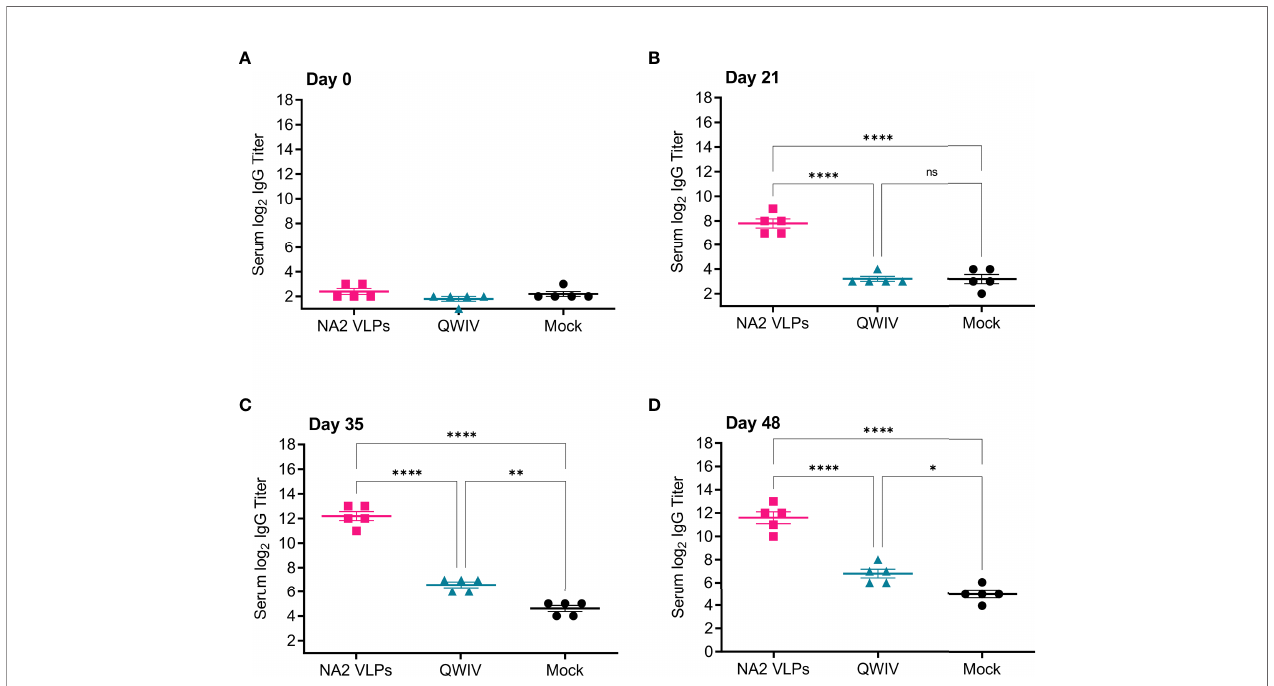
FIGURE 1 | Vaccination with NA2 VLPS induces anti-NA serum IgG titers in swine. Three groups of pigs (n=5) were vaccinated in a prime-boost regimen 21 days apart at day 0 and day 21 with a commercial quadrivalent whole inactivated virus vaccine (QWIV), NA2 VLPs, or mock vaccinated with water-in-oil-in-water adjuvant only (Mock). Serum was collected on day 0 before prime vaccination, day 21 at boost vaccination, day 35, and at day 48. Anti-NA IgG titers were measured via ELISA. (A) Total anti-NA serum IgG titers at day 0 prior to prime vaccination. (B) Total anti-NA serum IgG titers at day 21 prior to boost vaccination. (C) Total anti-NA IgG titers two weeks post-boost vaccination on day 35. (D) Total anti-NA IgG titers prior to virus challenge with A/swine/NC/KH1552516/2016 on study day 48. Horizontal bars represent the mean IgG titer for each respective group. Statistical analysis was performed by one-way ANOVA test. * = p < 0.05; ** = p < 0.01; **** = p < 0.0001. ns = no statistical